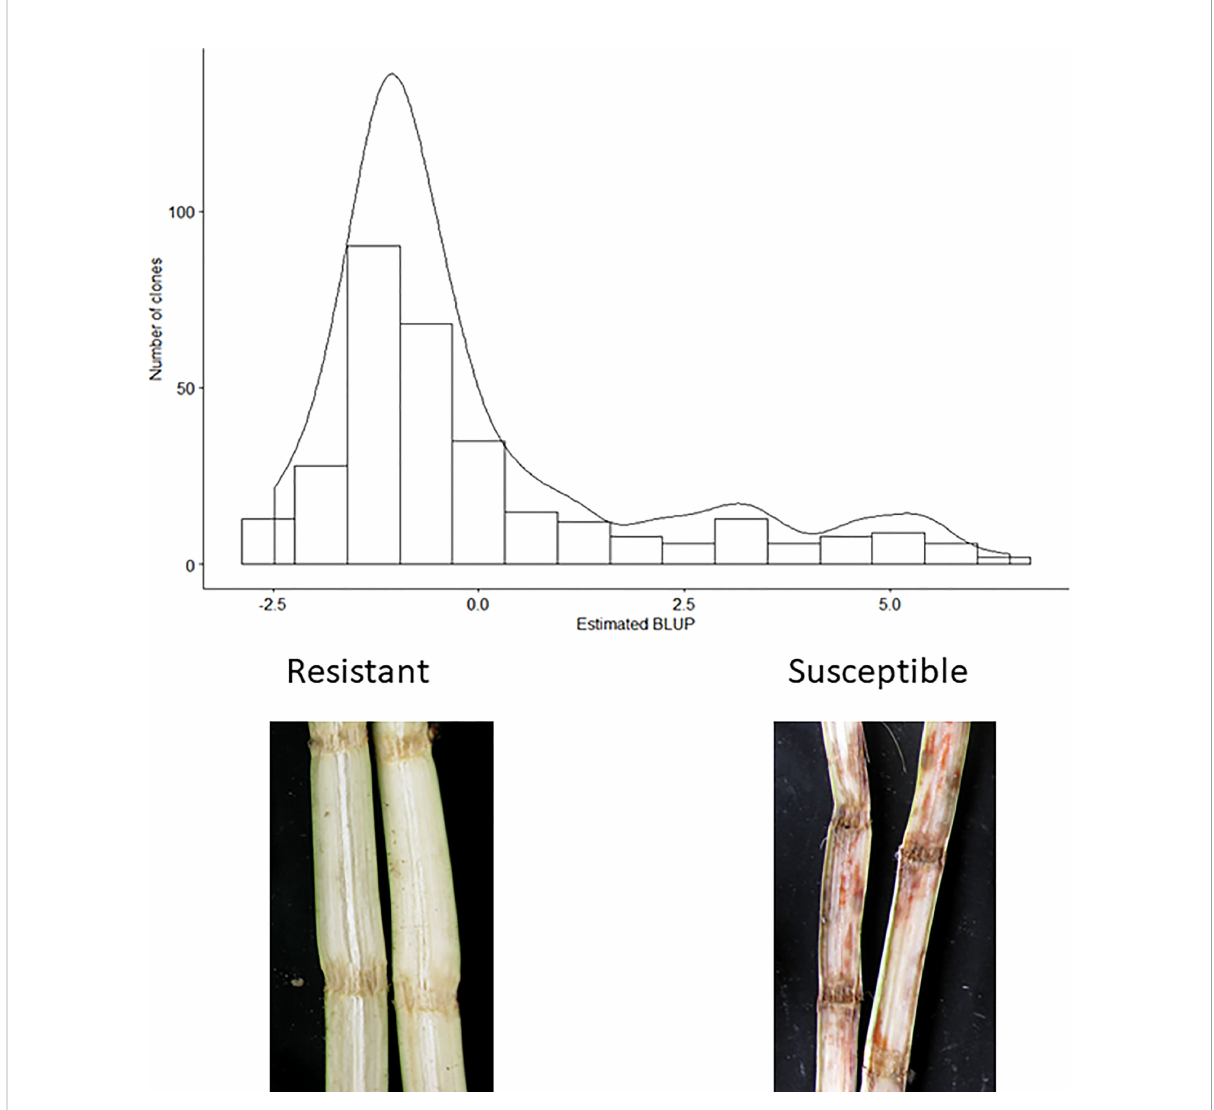
FIGURE 1 Distribution of estimated red rot BLUPs. Lowest BLUP values correspond to greater resistance levels. Photographs show typical symptoms observed in resistant and susceptible clones in the